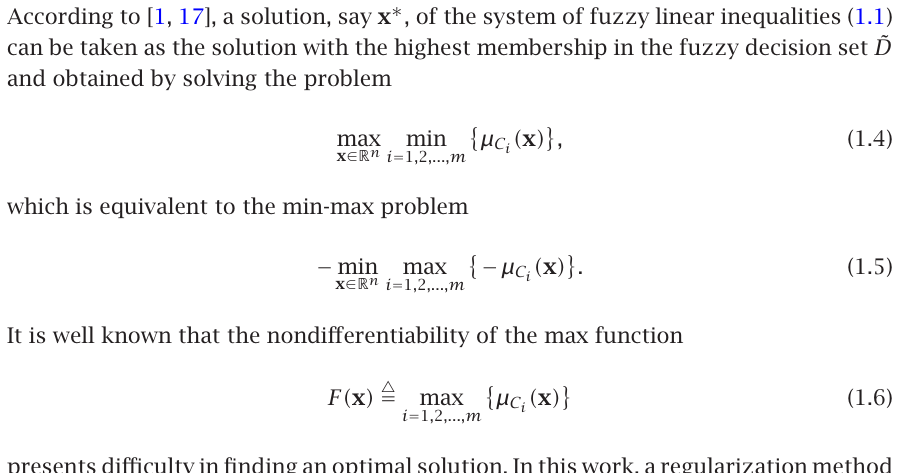
( x ) of the fuzzy inequality f i ( x ) ≤ ∼ i